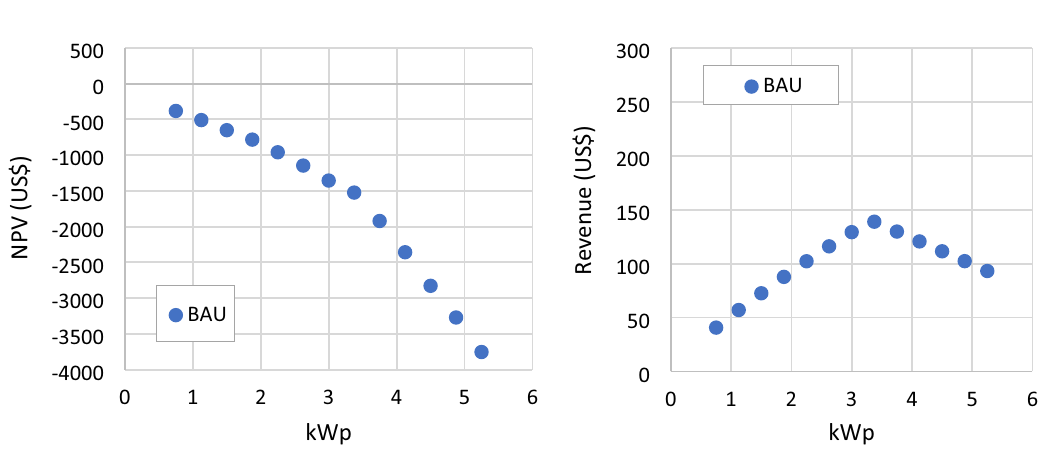
Figure 7. NPV and annual revenue of RSPP employing different numbers of PV modules in BAU